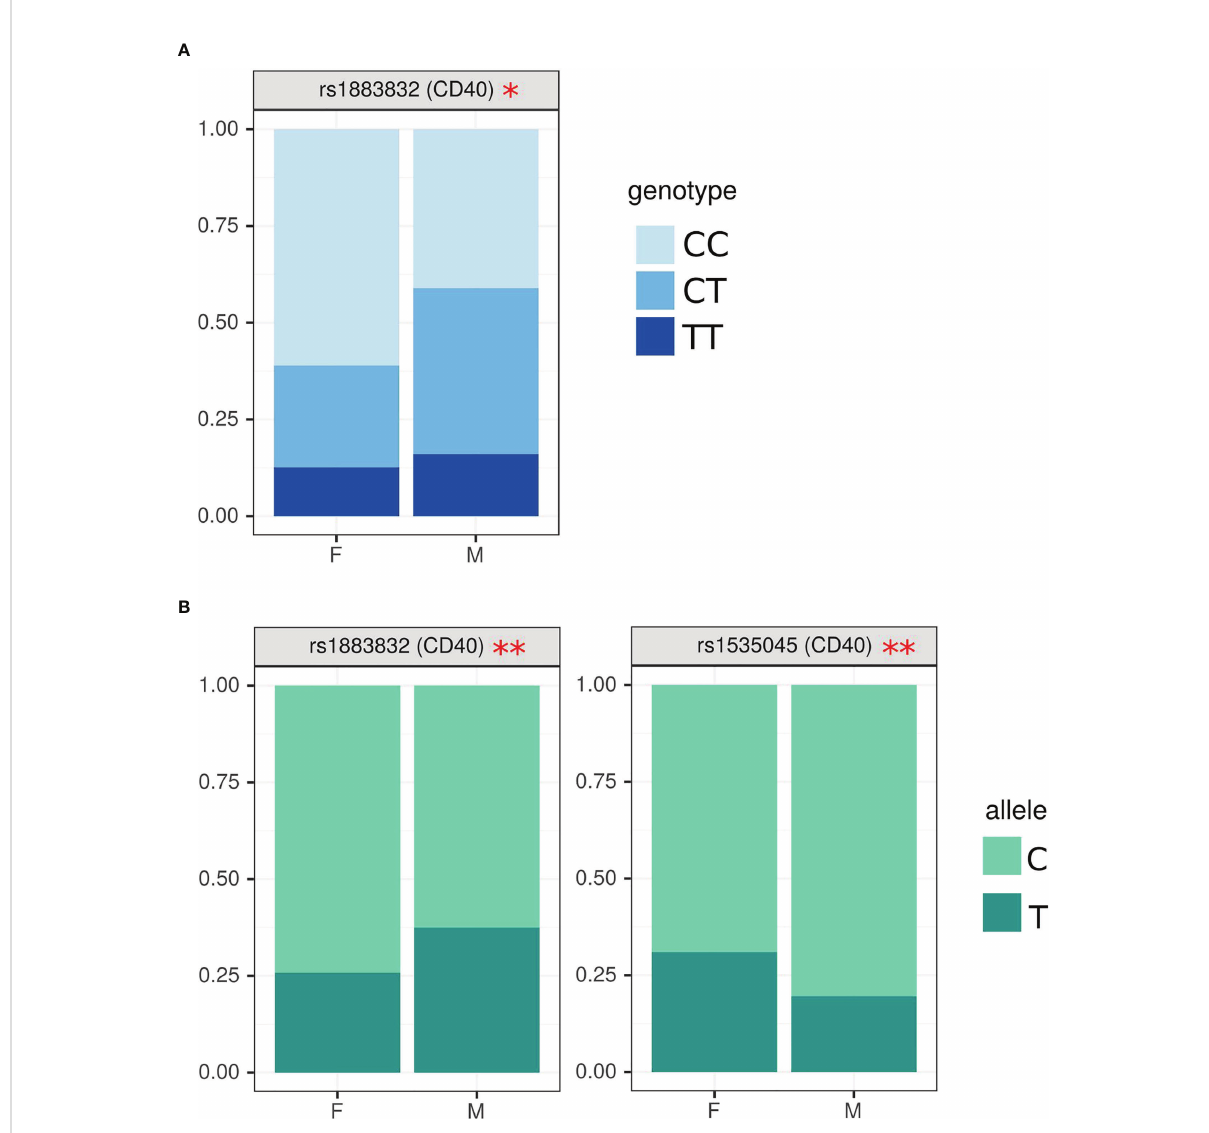
FIGURE 2 Analysis of SNPs genotype and allele frequency based on sex of MS patient. (A) – genotypes, (B) – alleles. SNPs analysis was done by AS-PCR. Data is presented as proportion of representation of genotype/allele. There were 151 MS patient samples used for the analysis. The analysis was done using Fisher ’ s exact test. ** - p<0.05, * -